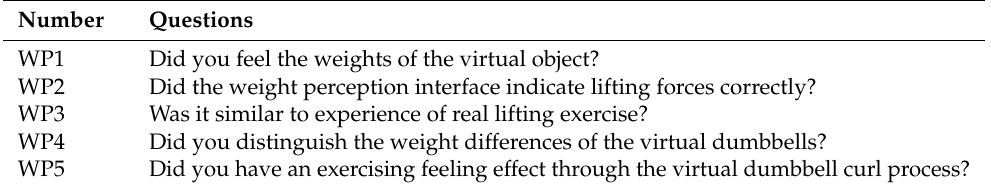
Table 3. Questionnaire on weight